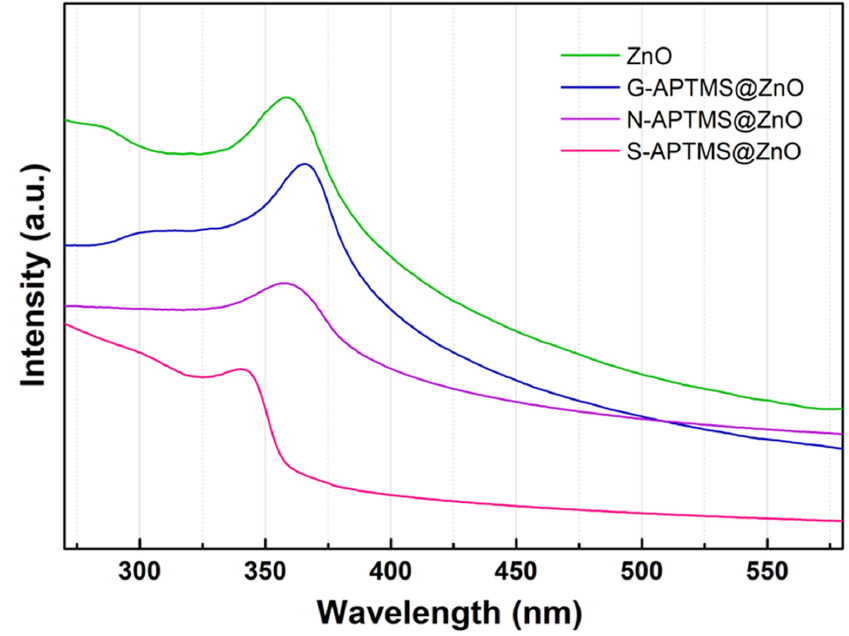
Figure 6. UV-visible spectra of G-APTMS@ZnO, N-APTMS@ZnO, and S-APTMS@ZnO. The corresponding band gaps can be estimated using the equation Eg (eV) = (hc/ λ m ) = 1240/ λ m (nm), where Eg is the optical band gap, h is the Planck’s constant, c is the speed of light and λ m is the wavelength of maximum absorption [88,89]. Band gaps and λ m are recorded in Table 5, along with literature data about ZnO synthesized using different methods, and whose UV-visible spectra were collected from dispersions in solvents. A main exitonic peak at 378 nm is observed for the water dispersion of ZnO nanoparticles with spherical shape in the range 30–90 nm. They were obtained by reacting Zn(NO 3 ) 2 · 6H 2 O and egg white, followed by calcination at 600 °C [88]. An exitonic peak at 368 nm was observed in the case of ethanol dispersion of a mix of nearly spherical and rod-shaped ZnO aggregates, obtained by Zn(ac) 2 thermolysis. In our case, the excitonic peak of ZnO is observed at 358 nm, i.e., it is blue-shifted. In general, this is attributed to confinement effects, which occur when the average size of the nanoparticles decreases, and it is compatible with the smaller size of our samples as compared to the ones in the literature. Taking the ZnO value of 358 nm as a reference, the effect of the coating is threefold, depending on the synthesis procedure. In particular, the excitonic peak is nearly unaffected in the case of N-APTMS@ZnO, likely due to the scattered coverage of the ZnO surface by the silane as observed by SEM imaging. The excitonic peak (and band gap) is blue-shifted in the case of S-APTMS@ZnO and it is red-shifted in the case of